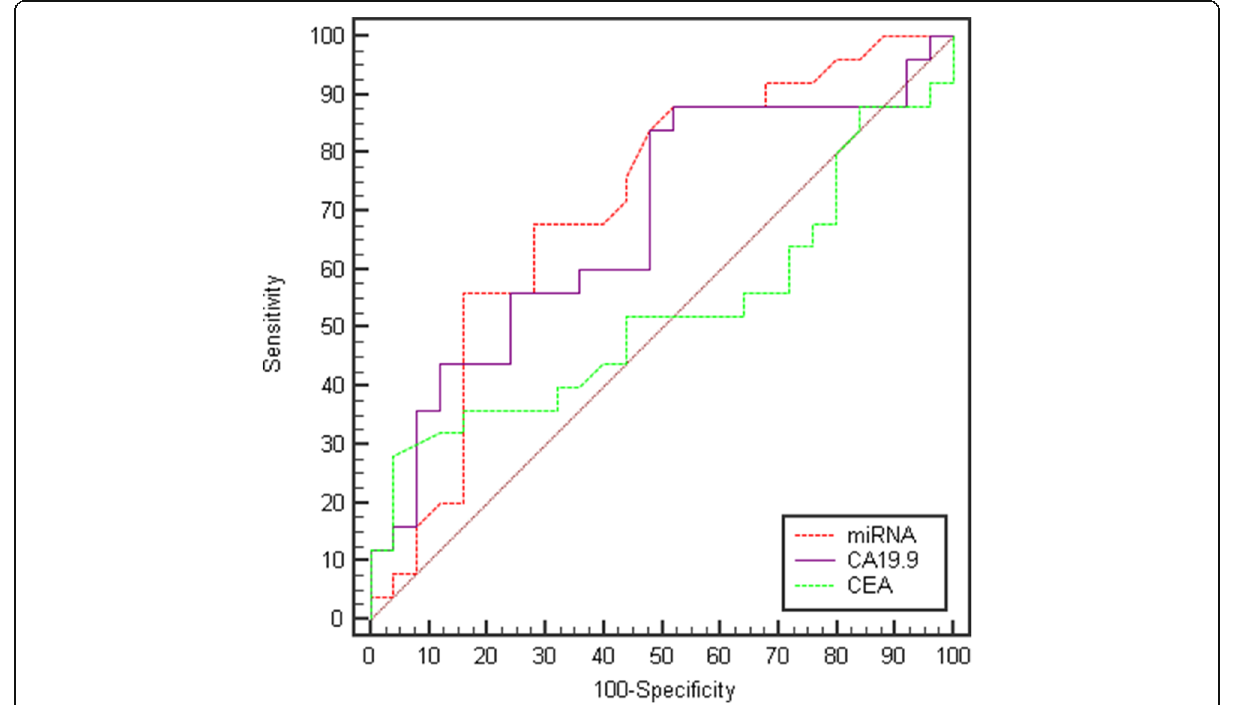
Fig. 2 ROC curve to predict stage IV from stage II +